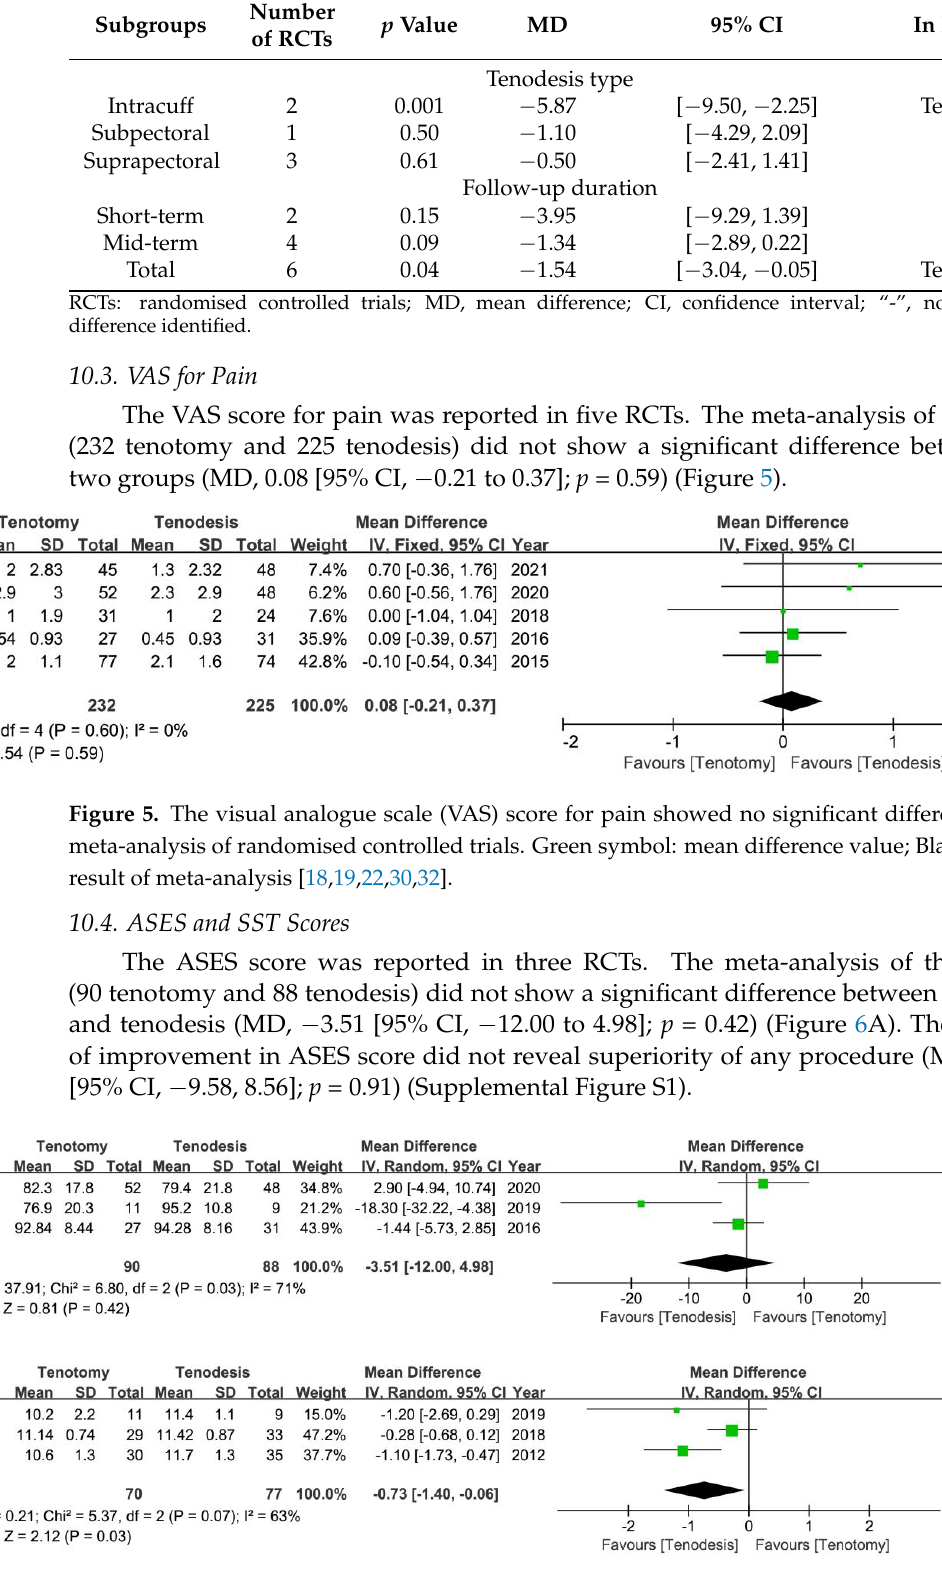
Figure 6. Meta-analysis of the ( A ) American Shoulder and Elbow Surgeons (ASES) score; ( B ) Simple Shoulder Test (SST) score. Green symbol: mean difference value; Black symbol: result of meta-analysis.